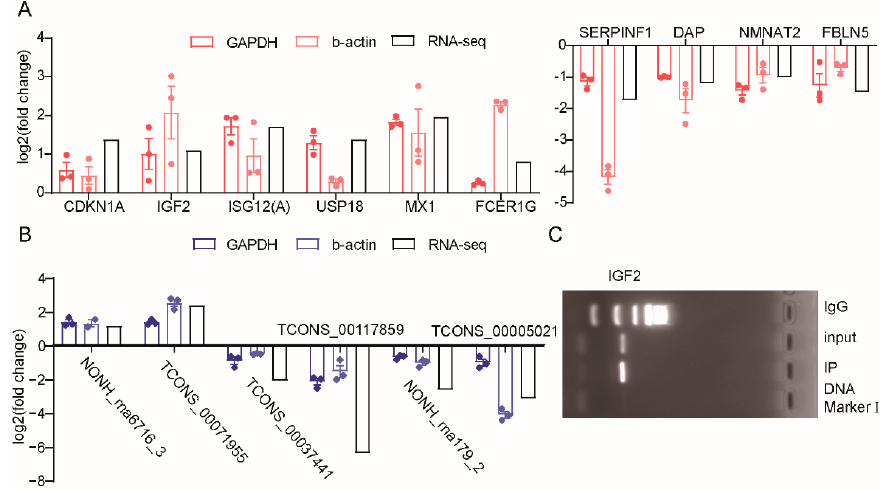
Figure 5. The verification of differentially expressed genes expression profiles. ( A ) Expression levels of six upregulated and four downregulated DEGs based on RNA-seq data and RT-qPCR. ( B ) Expression levels of two upregulated and three downregulated DELs based on RNA-seq data and RT-qPCR. Log2 fold change > 0 or <0 indicate the upregulated or downregulated in ZBED6 -KO group compared to ZBED6 -WT group. ( C ) The ChIP-PCR result of IGF2 gene.